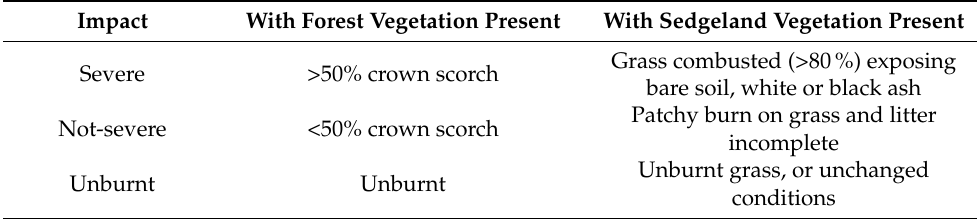
Table 2. Descriptions of fire severity classification based upon land cover